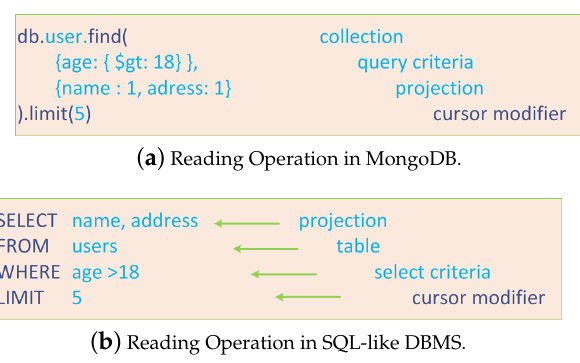
Figure 6. Comparison between reading operations in MongoDB and SQL-like DBMS